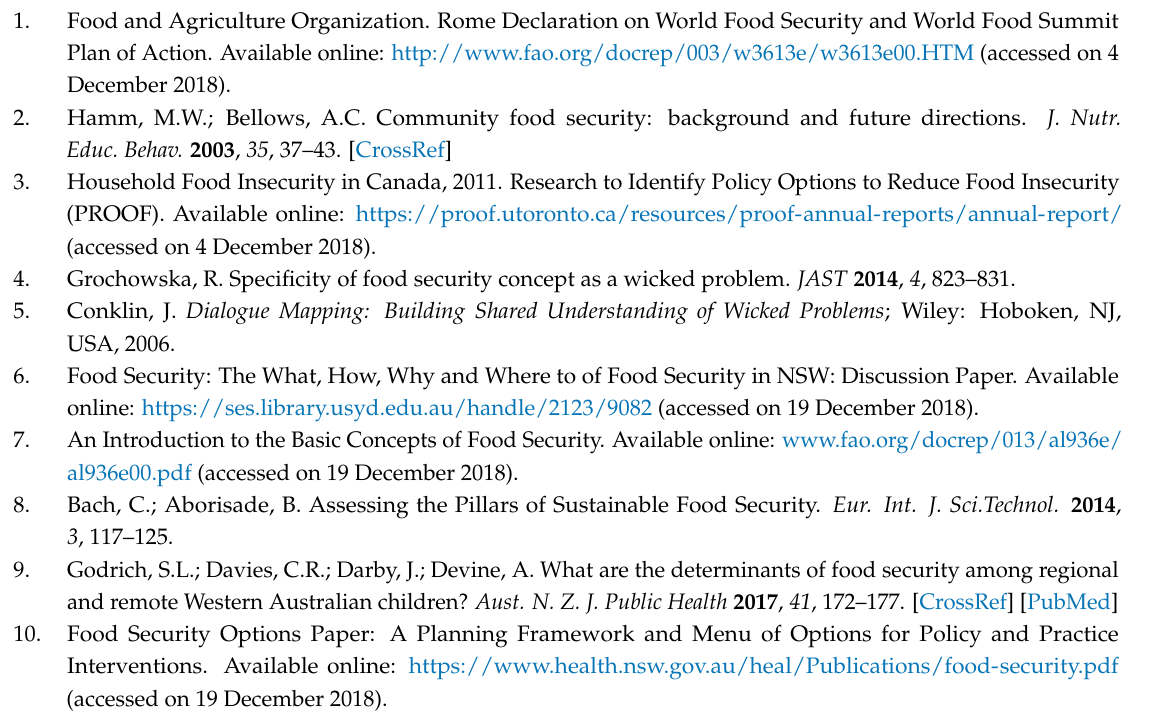
Table S1: Focus Areas, embedded characteristics, and associated survey interview